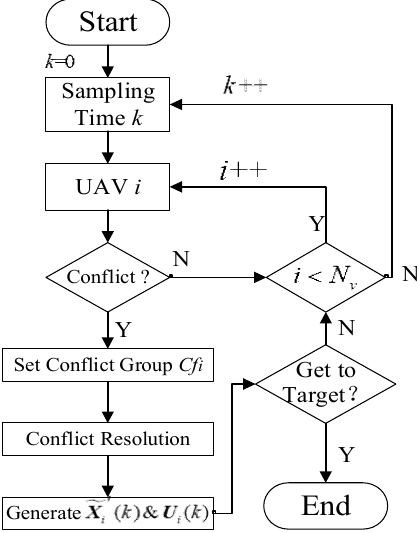
Figure 8. Flow chart of the conflict resolution algorithm.